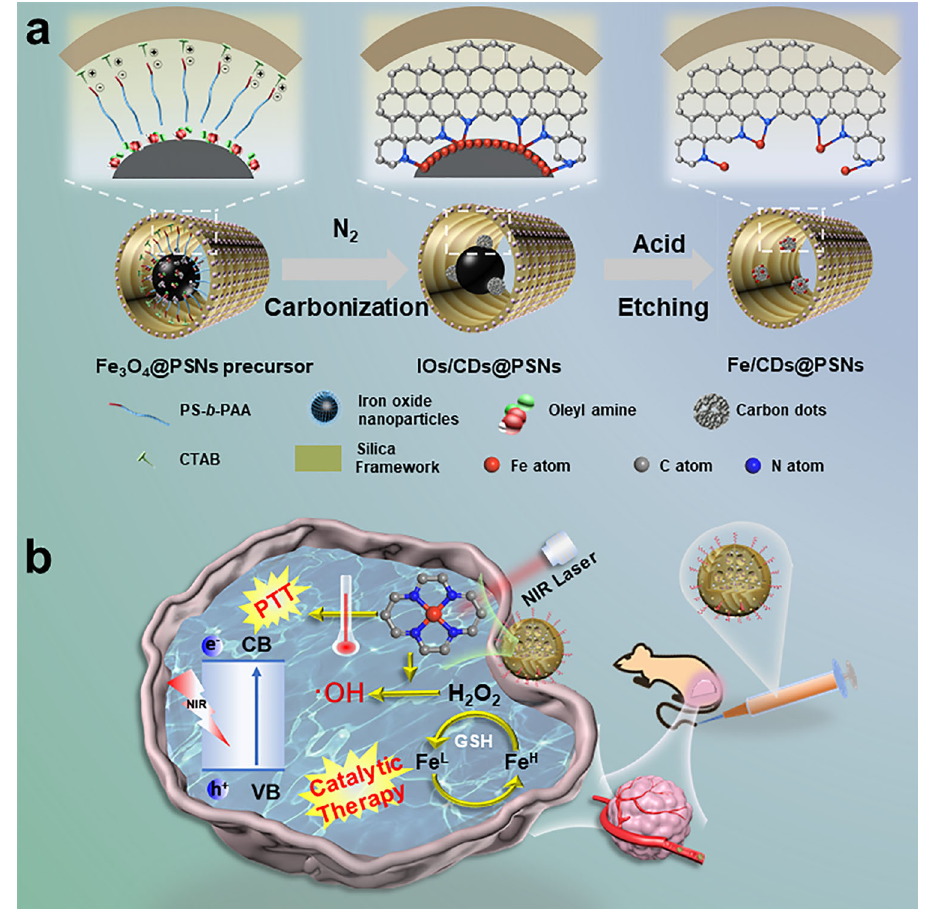
Fig. 1 Schematic illustration for the synthesis and biological effect of Fe/CDs@PPSNs. a Synthetic procedure. b Therapeutic effects by combined photothermal and catalytic tumor